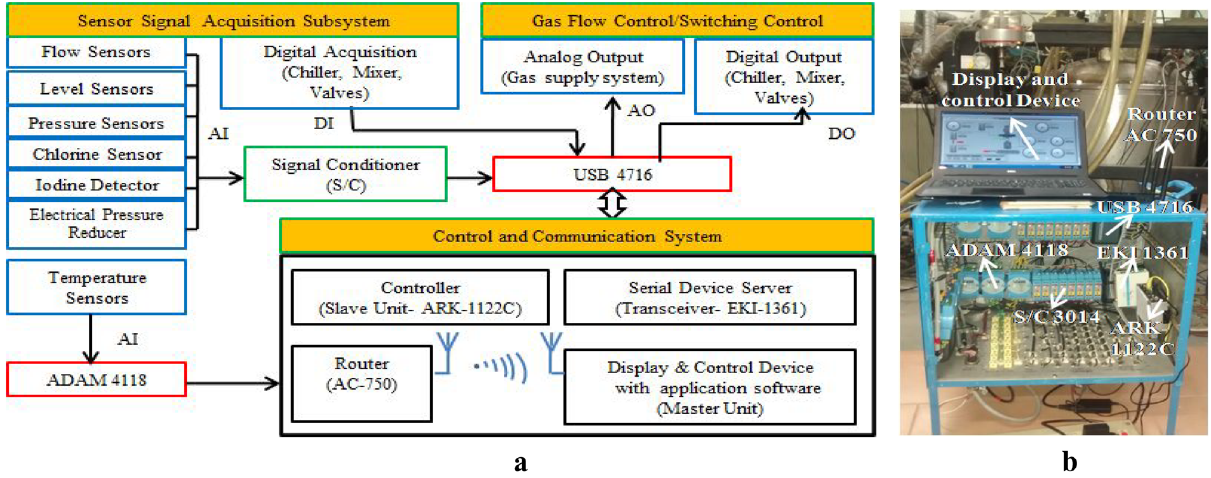
Figure 2. ( a ) Block diagram of DAAS architecture. ( b ) Developed